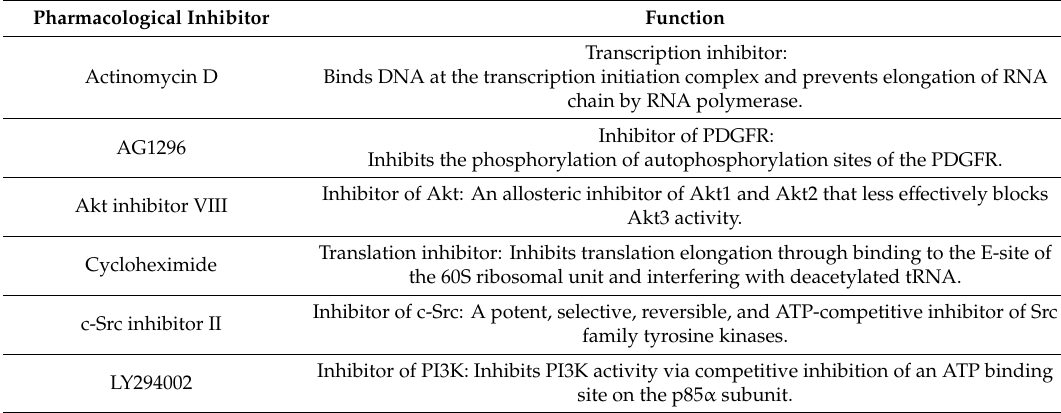
Table 1. Pharmacological inhibitors and their